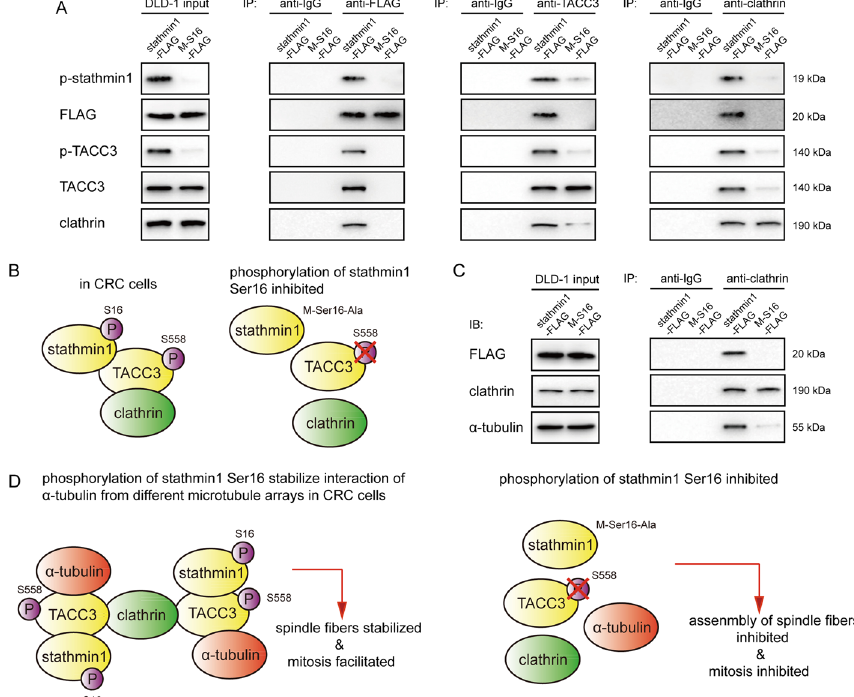
Fig. 6 Phosphorylation of stathmin1 at Ser16 facilitates the formation of TACC3/clathrin/α-tubulin complexes and enhances the stability of spindle fiber arrays. A Co-immunoprecipitation and immunoblot analyses of indicated factors in DLD1 cells transfected with pCMV-stathmin-FLAG or pCMV-stathmin1-M-S16-Ala-FLAG vectors (final vector concentrations, 2 μg/ml) for 48 h. The indicated factors were immunoprecipitated using Protein A/G beads conjugated with indicated antibodies. B Schematic representation of the stathmin1-TACC3-clathrin interaction. Phosphorylation of stathmin1 at Ser16 facilitated its interactions with TACC3 and clathrin. C Co-immunoprecipitation and immunoblot analyses of indicated factors in DLD1 cells transfected with vectors as shown in A for 48 h. The indicated factors were immunoprecipitated using Protein A/G beads conjugated with indicated antibodies. D Schematic representation of stathmin1-TACC3-clathr in-α-tubulin interactions. Phosphorylation of stathmin1 at Ser16 facilitated the formation of